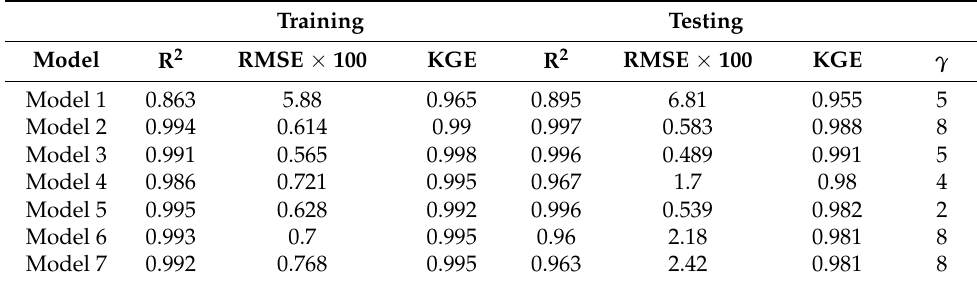
Table 5. The statistical parameters for the first